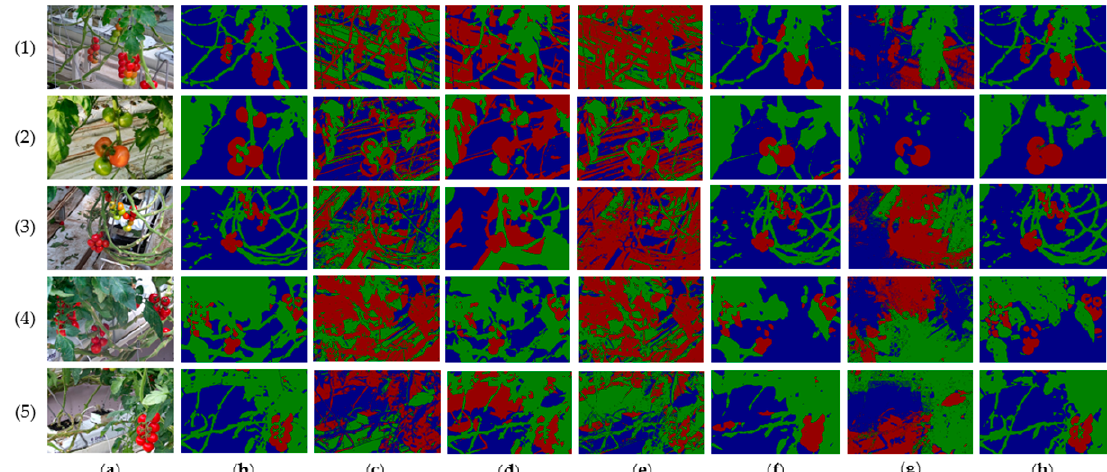
Figure 17. The result of different algorithms with distant shots. Column ( a ) are original images. Column ( b ) are high quality ground-truth. Columns ( c – h ) are the results of several segmentation methods: quantum-behaved particle swarm optimization (QPSO), fuzzy c-means clustering (FCM), pulse coupled neural network-based segmentation (PCNN), co-segmentation, the traditional latent Dirichlet allocation (LDA), and self-adaptive latent Dirichlet allocation (SA-LDA), respectively.